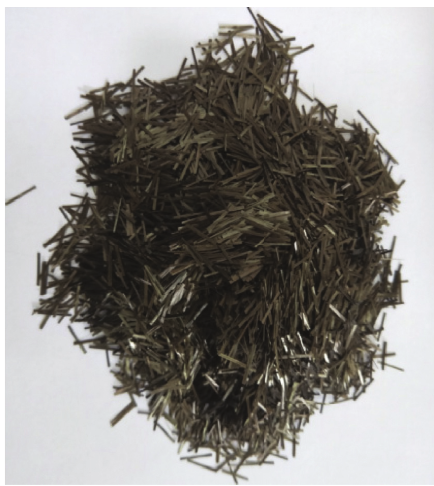
Figure 1: Basalt fibers. Table 1: Technical indices of asphalt.